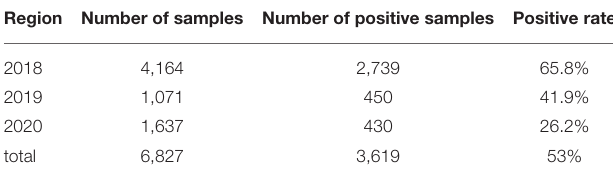
TABLE 3 | Temporal prevalence rates of PCV2 in China during 2018 to 2020.